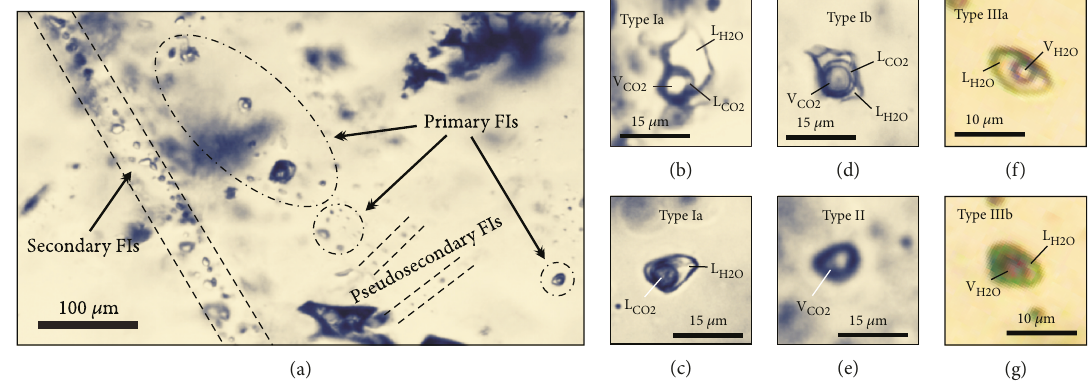
Figure 7: Photomicrographs of typical fl uid inclusions in the Xiejiagou gold deposit. (a) Primary, pseudosecondary, and secondary fl uid inclusions in the same sample; (b) three-phase type Ι a fl uid inclusion; (c) two-phase type Ι a fl uid inclusion; (d) three-phase type Ι b fl uid inclusion; (e) type ΙΙ fl uid inclusion; (f) type ΙΙΙ a fl uid inclusion; (g) type ΙΙΙ b fl uid inclusion.V vapor H O; L : liquid H 2 H2O 2